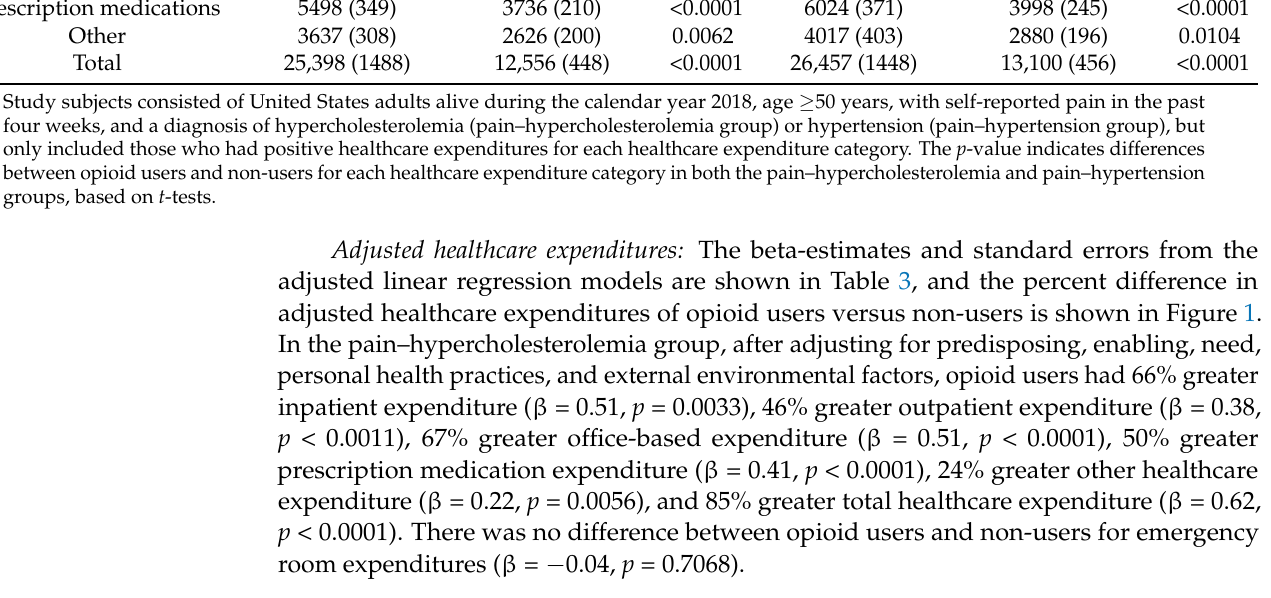
Table 3. Adjusted parameter estimates using logged positive healthcare expenditures of United States older adults (age ≥ 50 years) with self-reported pain in the past four weeks and a diagnosis of hypercholesterolemia or